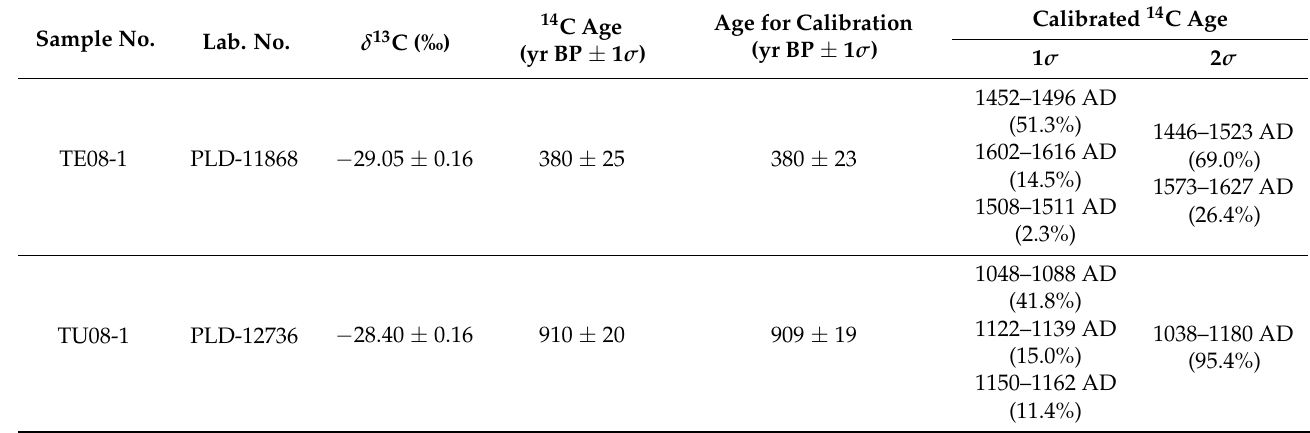
Table 1. Radiocarbon ages without δ 13 C correction and calibrated ages for each 50 cm depth in the cores TE08 and TU08. Sample No. Lab.